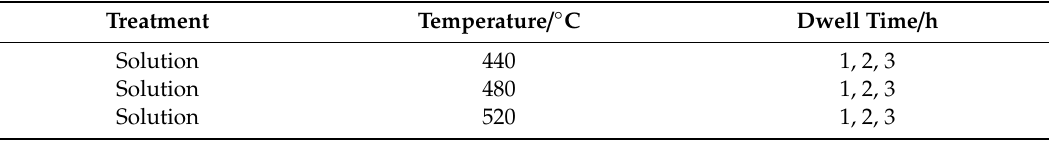
Table 4. The solution treatment parameters of Mg-30%Y alloy forming parts.